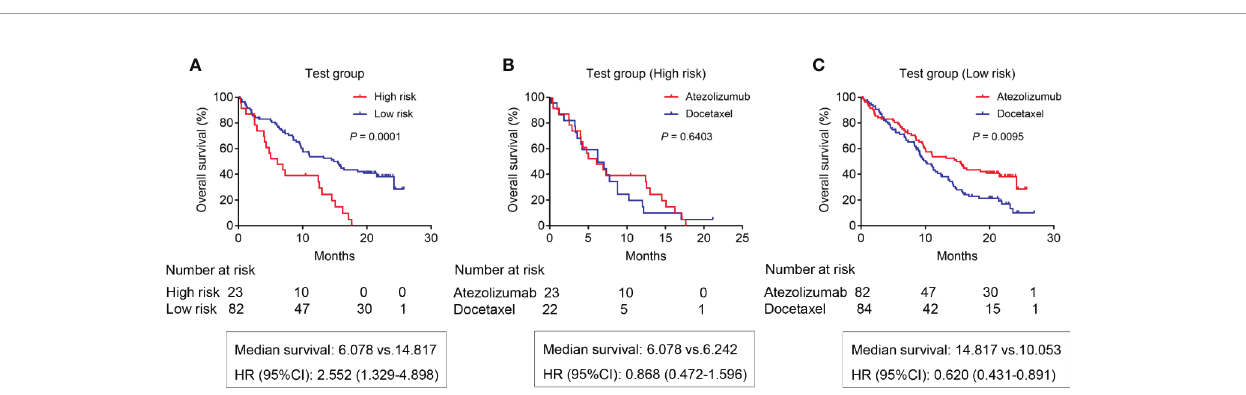
FIGURE 5 | The OS analysis for patients in the testing group from POPLAR study. (A) The OS difference between the high risk and low risk patients receiving atezolizumab ( P = 0.0001). (B) The OS difference of high-risk patients between atezolizumab and docetaxel ( P = 0.6403). (C) The OS difference of low-risk patients between atezolizumab and docetaxel ( P = 0.0095).